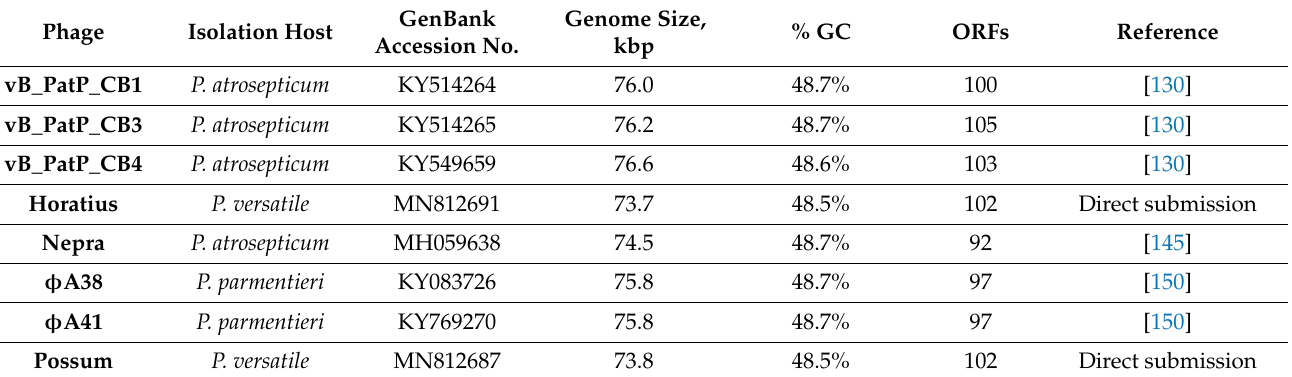
Table 5. Genomic properties of Schitoviridae bacteriophages infecting